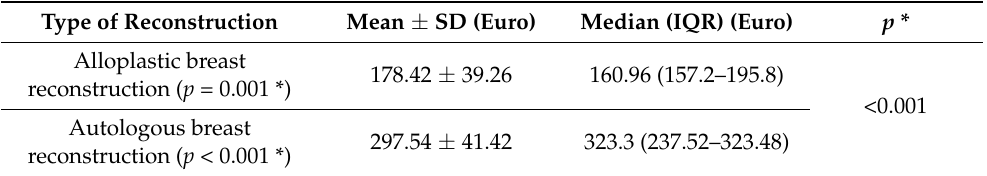
Table 4. The costs of breast reconstruction in the RT